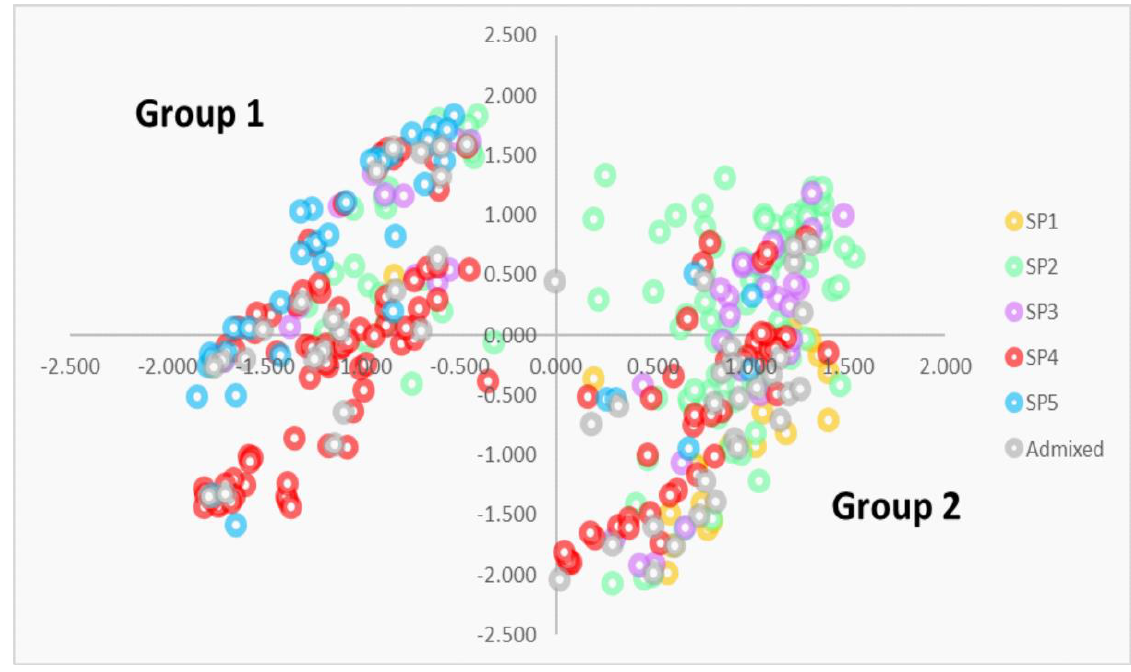
Figure 4. PCoA derived from the markers with –log 10 p > 5 in the eigenGWAS. The PCoA separated two clear groups: group 1, on the left of the Y -axis, included 173 genotypes (mainly modern cultivars (79%)), whereas group 2, on the right of the Y -axis, included 214 genotypes, of which 69% corresponded to landraces. By SPs, those repre- sented mainly by landraces (SP 1, SP 2 and SP 3) were mostly included in group 2 (95%, 77%, and 63%, respectively), whereas SPs represented mainly by modern cultivars (SP 4 and SP 5), were mostly included in group 1 (63% and 85%, respectively). All north Amer- ican cultivars from SP 5 were located within group 1. Most of the landraces from the north- ern Mediterranean included in SP 2 were also represented in group 1. The selected 147 markers, corresponding to 35 QTL hotspots, were analyzed to iden- tify differences in the marker allele between both groups, as well as the different SPs (Sup- plementary Table S3). To identify robust differences among groups, a threshold of allele frequency within a group was established at 80%. When both alleles of the marker comply with this condition, the marker was considered significant for locus selection. Following this approach, 35 markers from five QTL hotspots were identified: eigenQTL2A.7, eigenQTL2B.3, eigenQTL3A.5, eigenQTL3A.6 and eigenQTL3A.7 (Table 3). However, when the markers were blasted against the reference genomes of bread wheat [22], durum wheat [23], and wild emmer [21], it was observed that markers corresponding to eigenQTL3A.5, eigenQTL3A.6, and eigenQTL3A.7 shared the same physical positions.